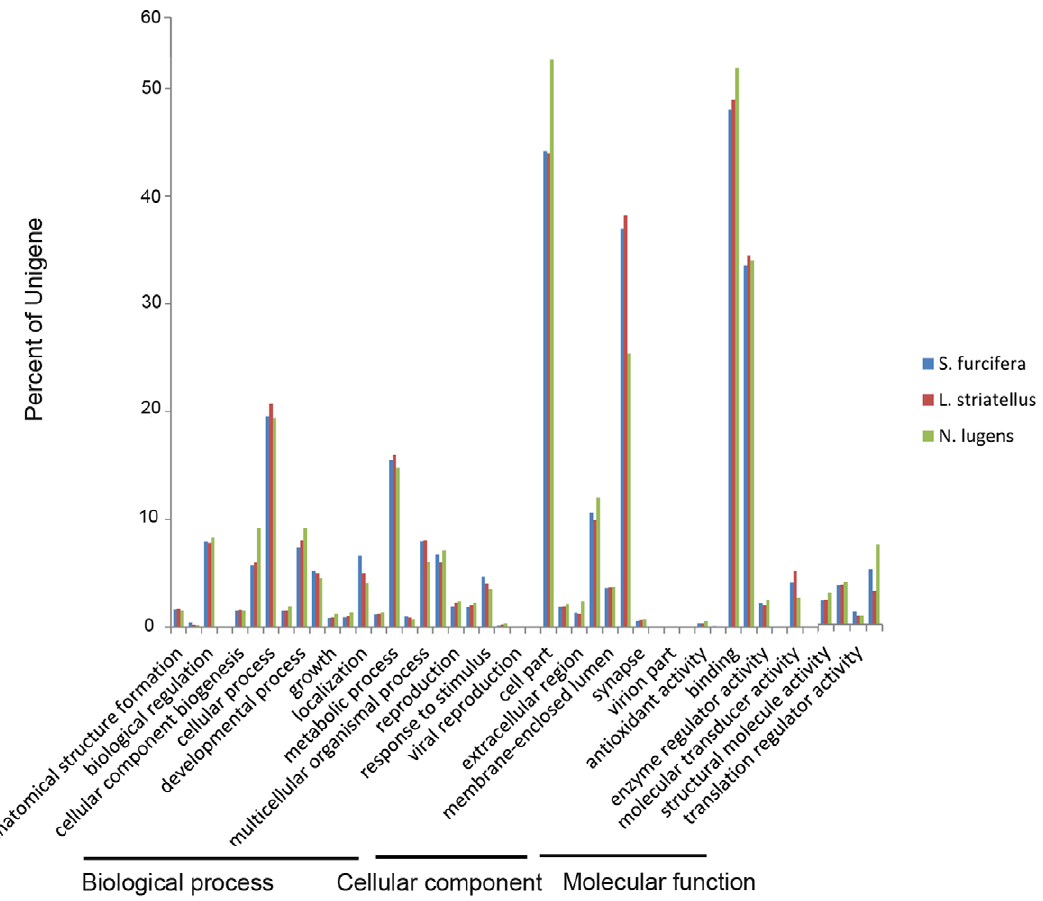
Figure 3. Histogram presentation of GO classification of putative functions of genes from three rice planthoppers. The functions of genes identified cover three main categories: biological process, cellular component, and molecular function. The y axis indicates the percentage of a specific category of genes in that main category.